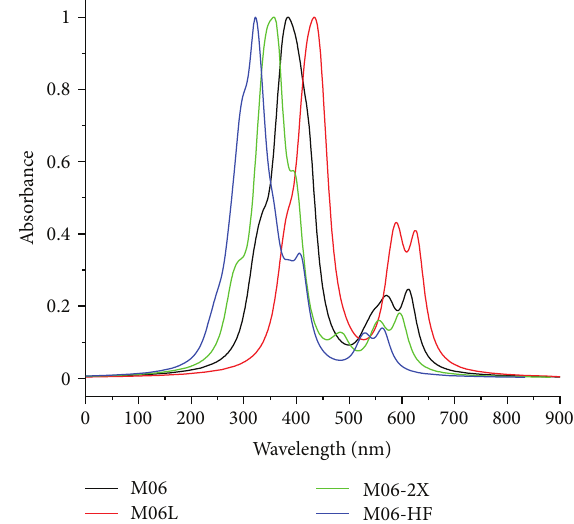
F 3: Absorption spectra of the chlorophyll a molecule calculated with the M06, M06L, M06-2X, and M06-HF density functionals and the MIDIY and DGDZVP basis